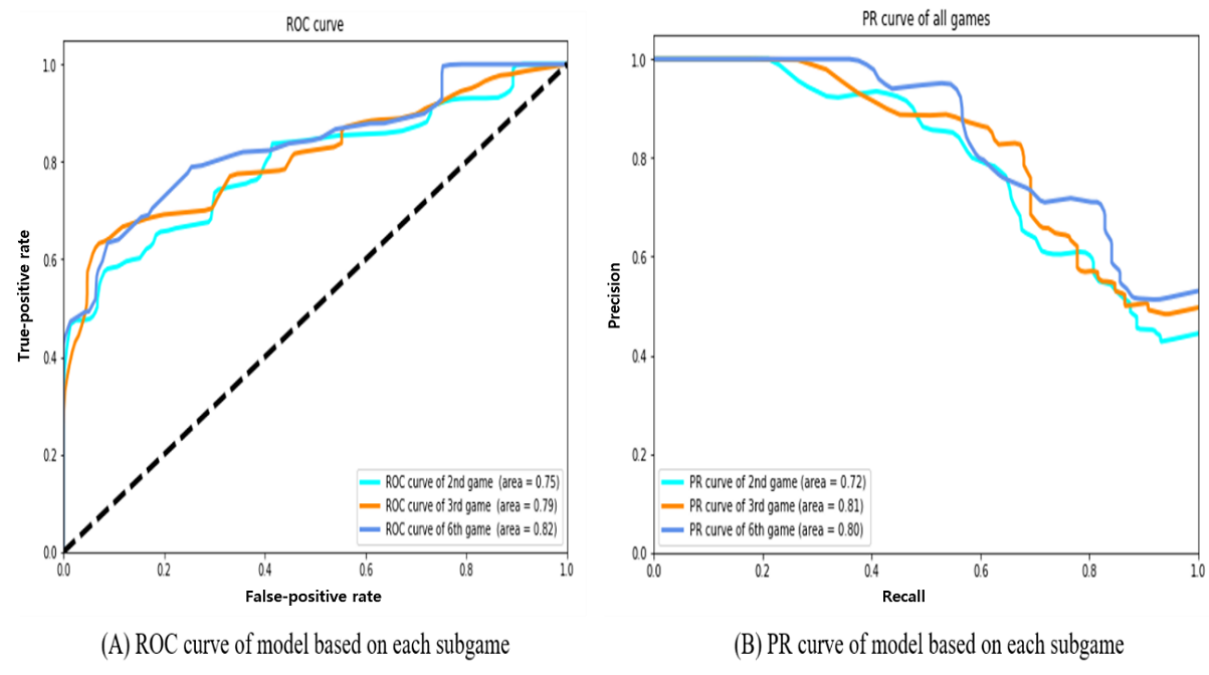
Figure 3. ROC curves and PR curves of the deep learning model. PR: precision-recall. ROC: receiver operating characteristic.